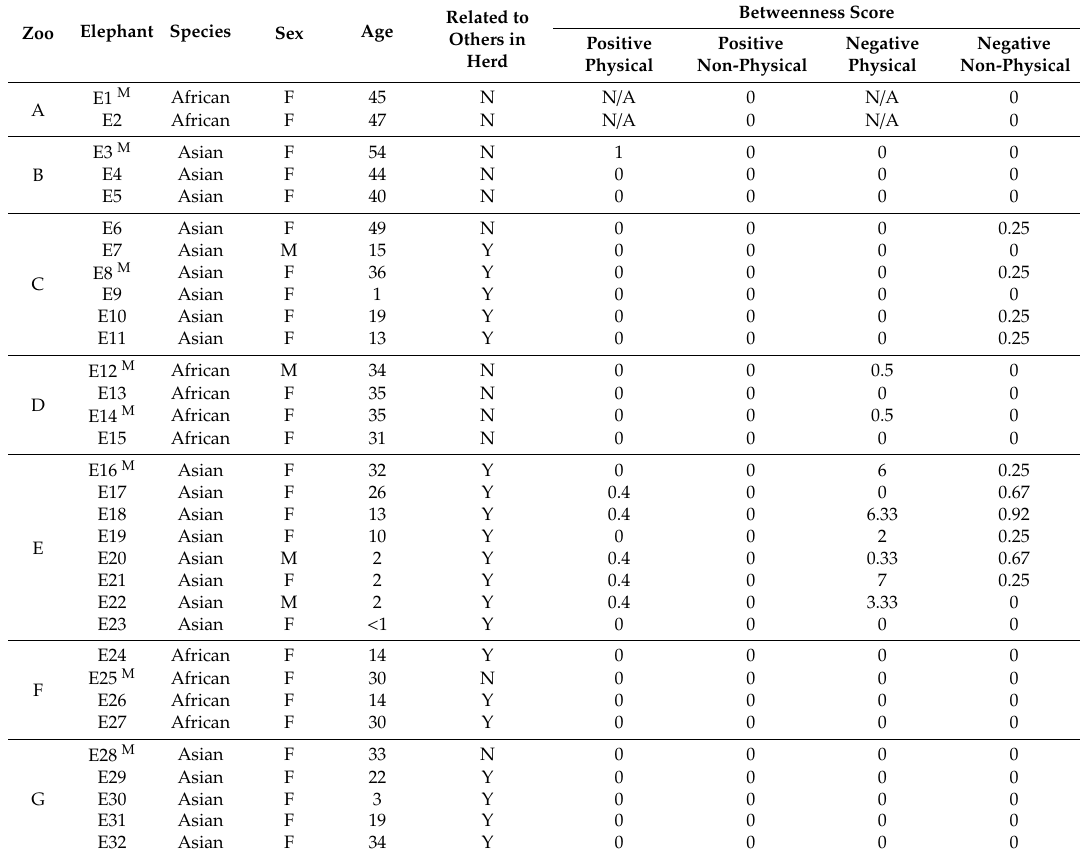
Table 8. Betweenness centrality scores for study